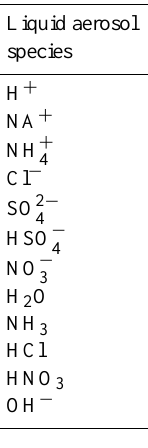
Table 3. List of the solid aerosol species given by the ISORROPIA model.